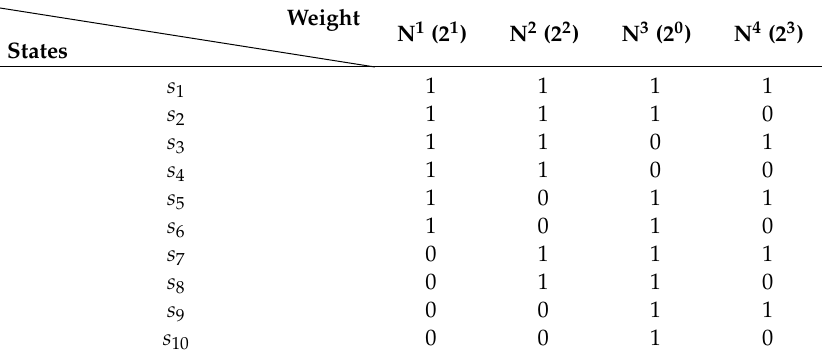
Table 4. True values of states for LG.